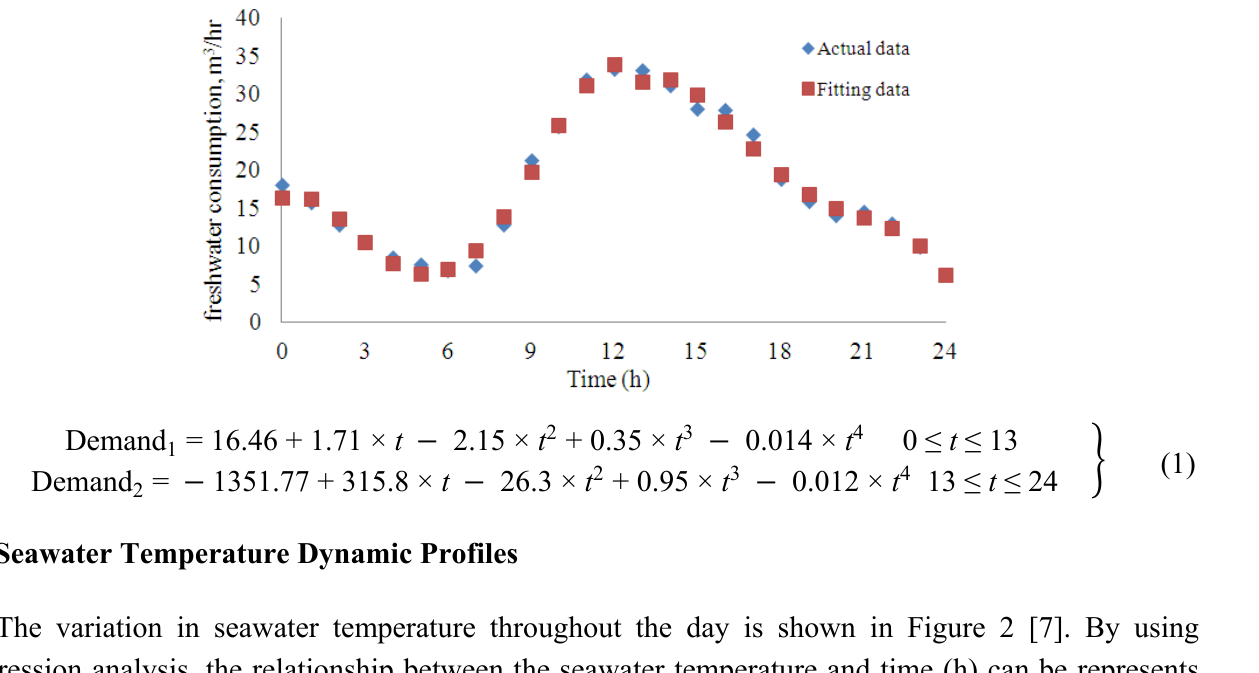
Figure 1. Fresh water consumption profile on holiday (Saturday).